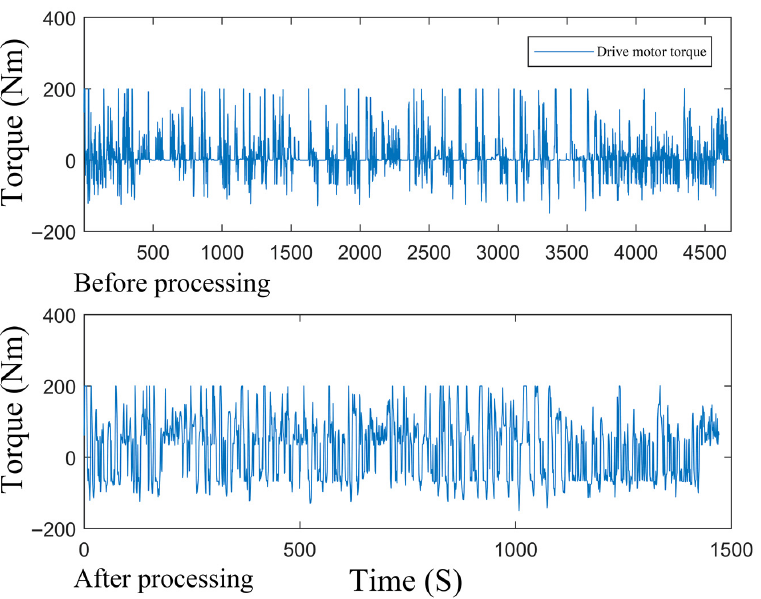
Figure 4. The effect diagram of removing the extreme values of invalid load in pure electric mode under provincial road conditions.